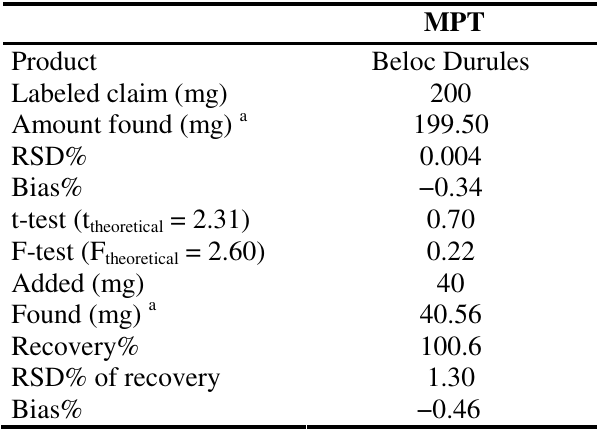
Table 2. Assay results from MPT dosage forms and mean